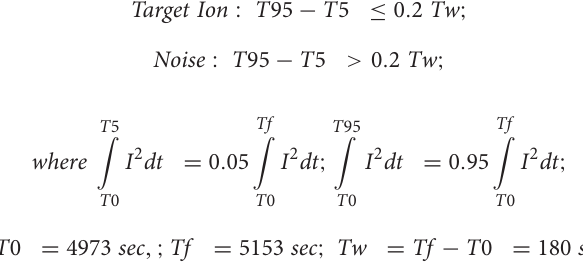
width in time at half height (code line 62-64). Both T R